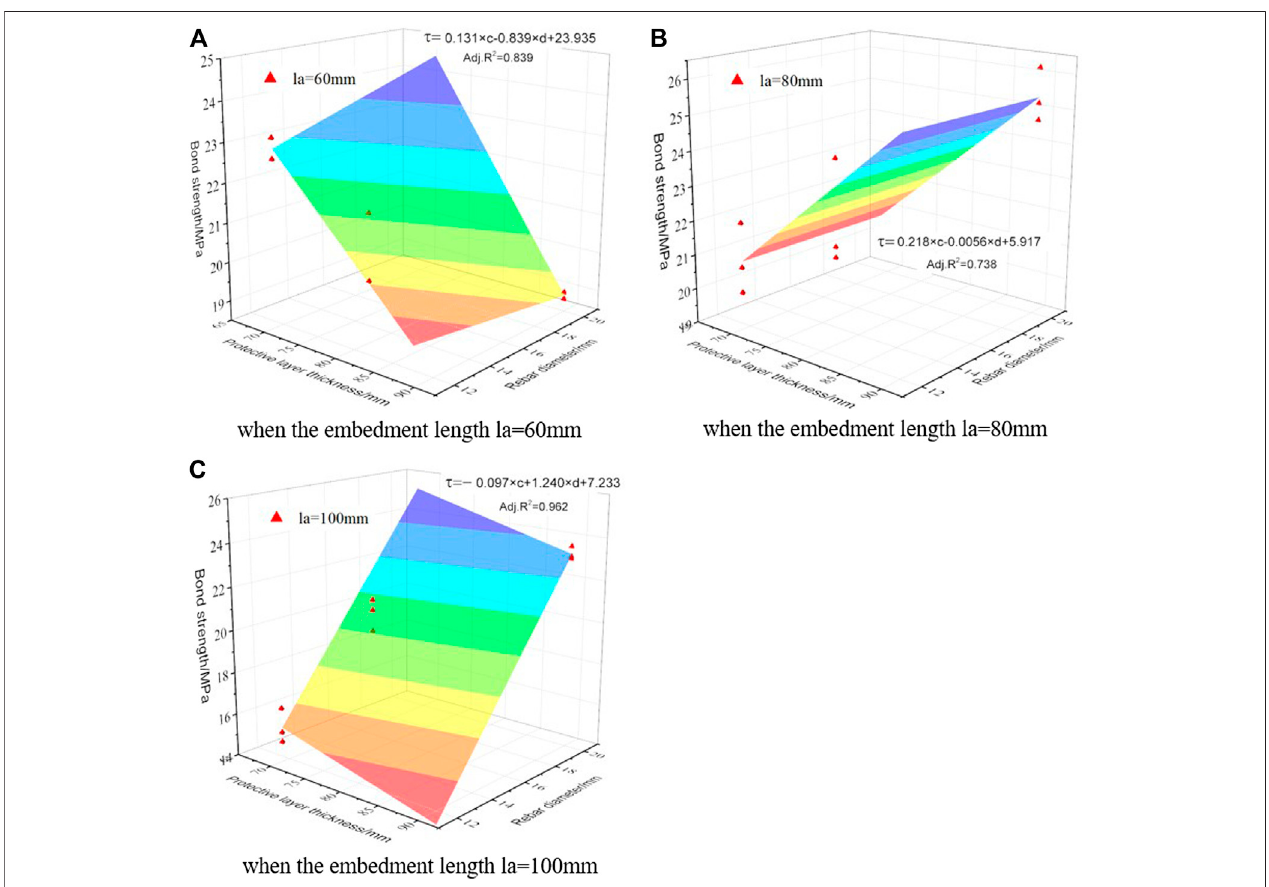
FIGURE 10 | Regression analysis between bond strength and cover layer thickness and rebar diameter.